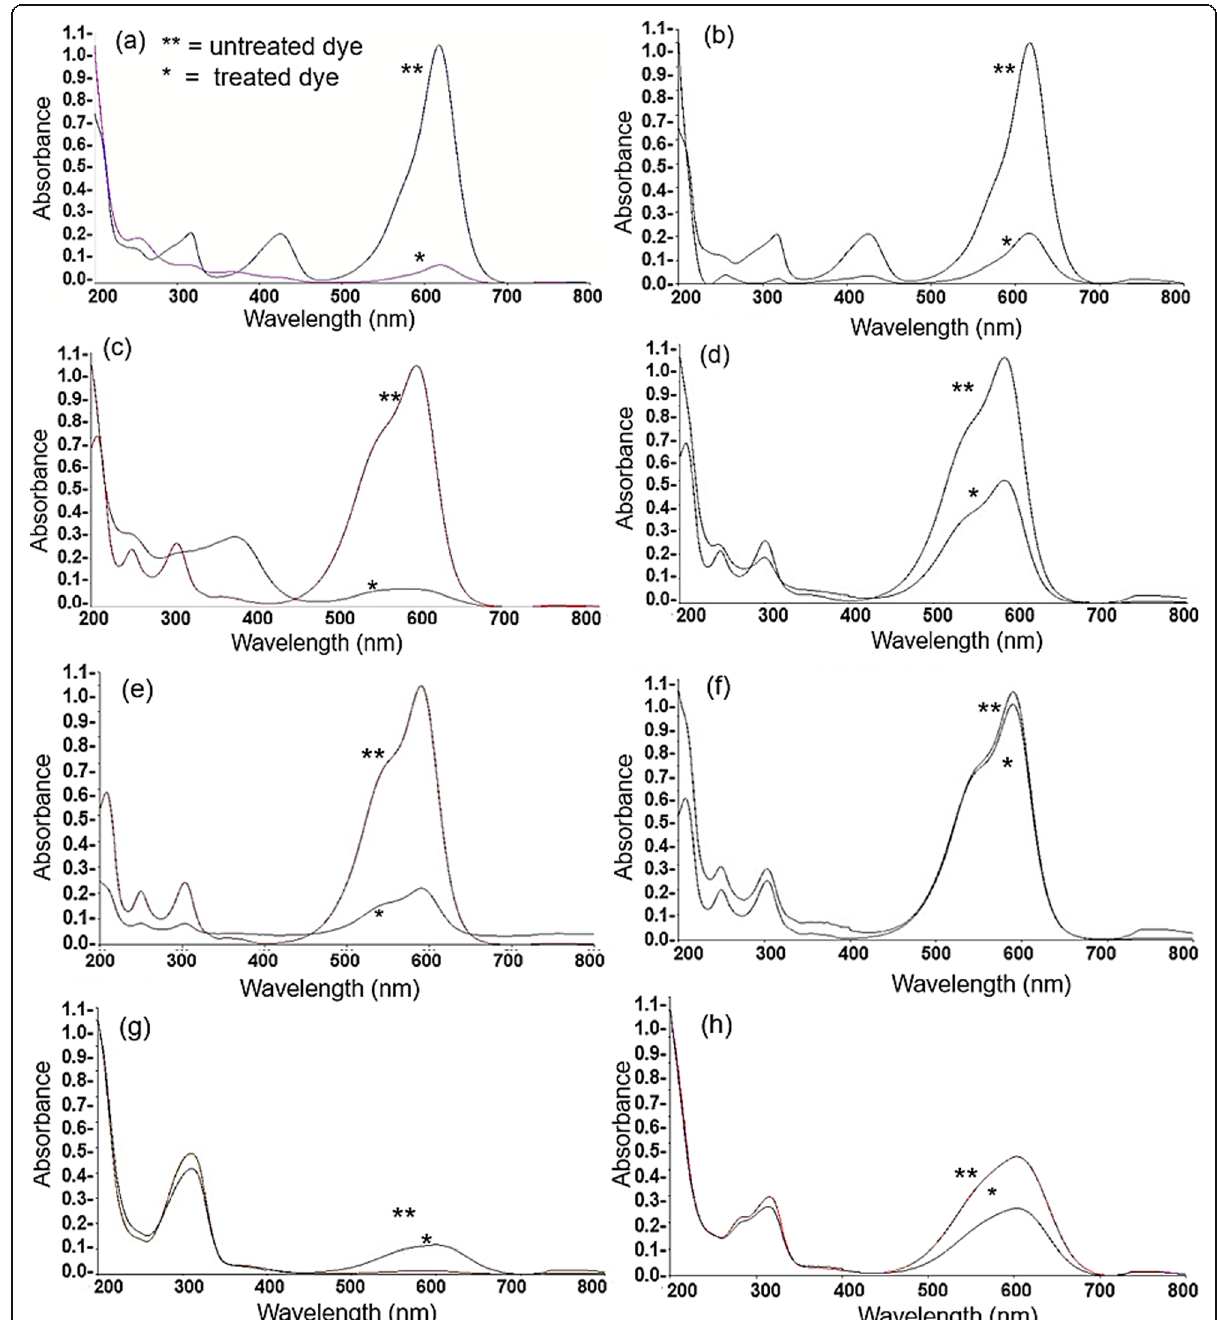
Fig. 12 UV-Vis absorption spectra (200 – 800 nm) of TPM dyes before (untreated) and after treatment (treated) by Streptomyces isolate: (a) MG (live cells) (b) MG (dead cells) (c) MV (live cells) (d) MV (dead cells) (e) CV (live cells) (f) CV (dead cells) (g) CB (live cells) and (h) CB (dead